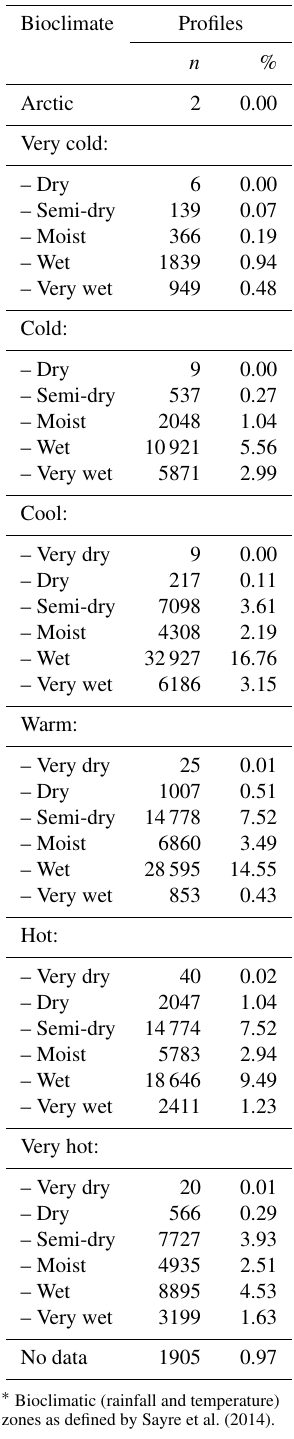
Table D1. Number of soil profiles by broad rainfall and temperature zone ∗ .